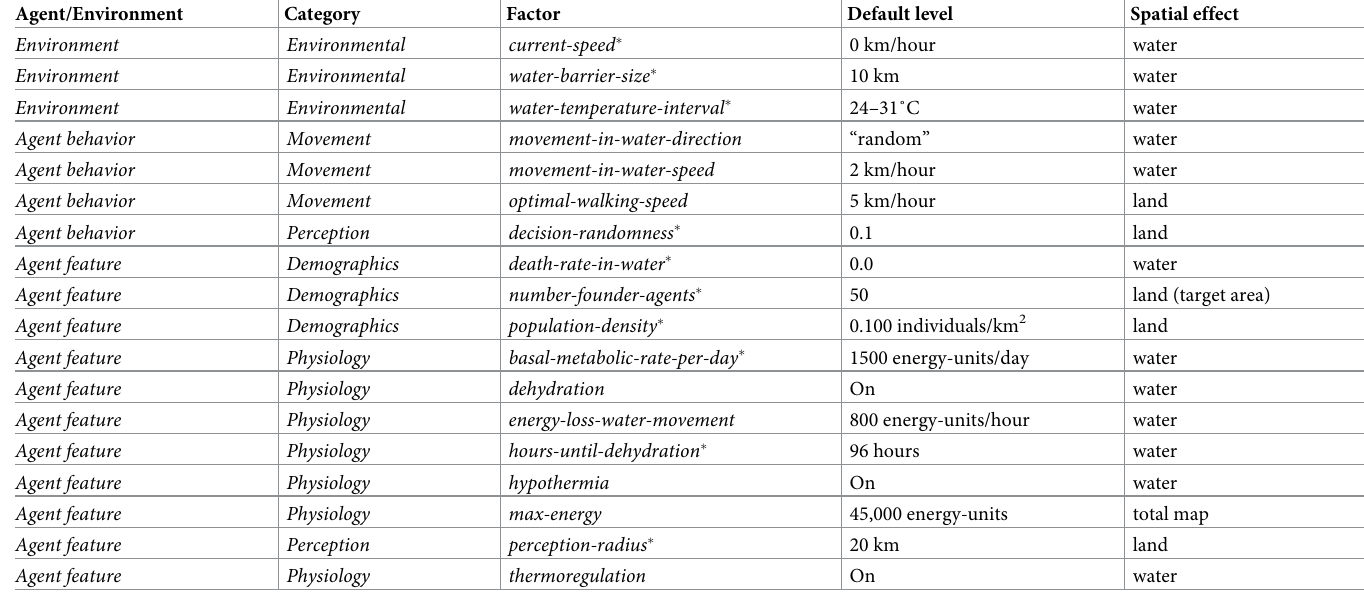
Table 2. Default levels of model